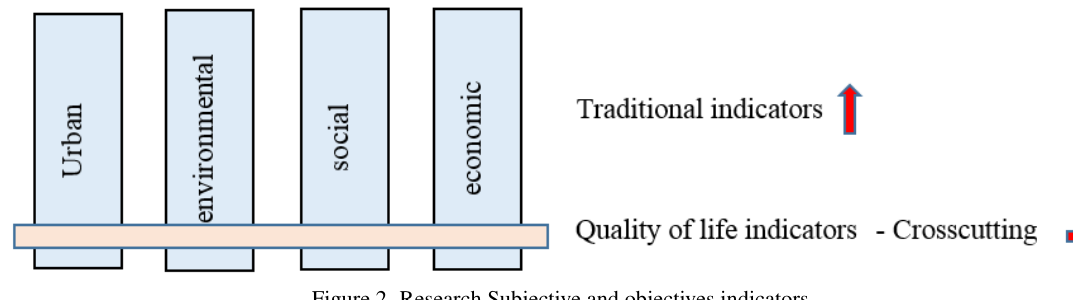
Figure 2. Research Subjective and objectives indicators